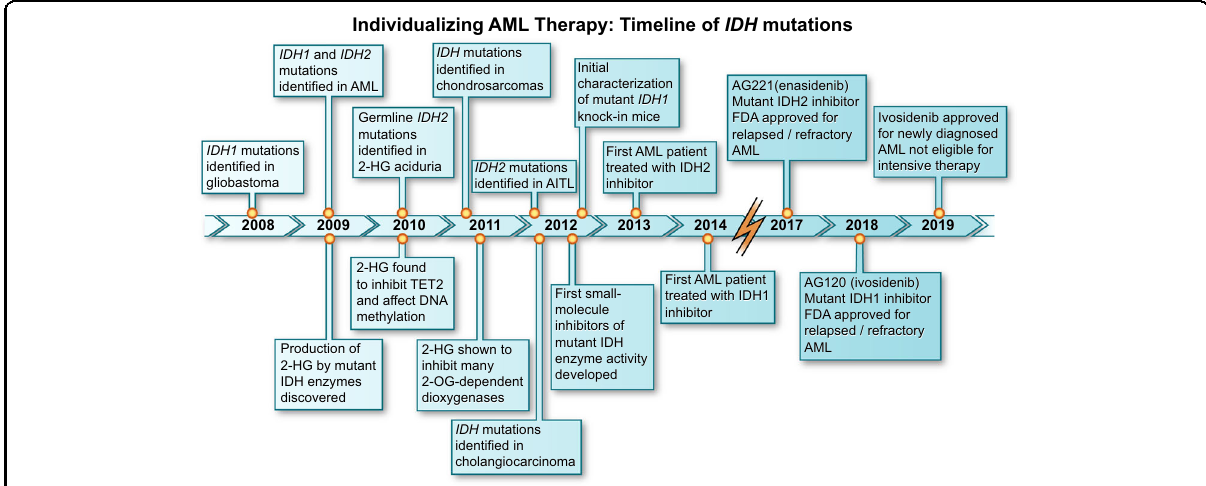
Fig. 1 A timeline depicting the decade of progress in IDH -mutated malignancies. IDH, Isocitrate Dehydrogenase; 2HG, 2-hydroxyglutarate; AML, acute myeloid leukemia; TET2, Ten-Eleven Translocation-2; 2-OG, 2-oxygluterate; AITL, angioimmunoblastic T-cell lymphoma.